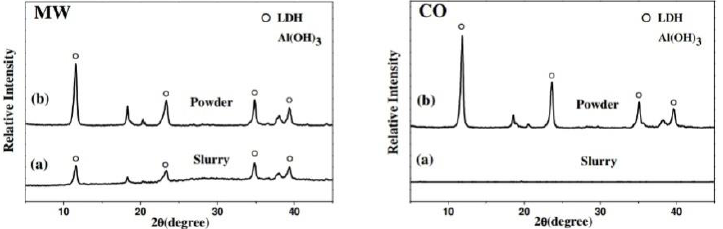
Figure 4. XRD patterns of products with microwave (MW) irradiation for 20 min and conventional heating (CO) for 2 h. (a) Before and (b) after drying at 100 °C “Ref. [42]” .